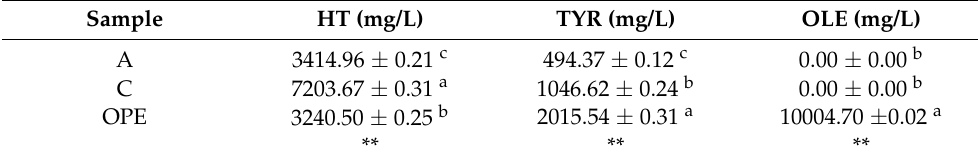
Table 2. Phenol detected in the three tested OMWW